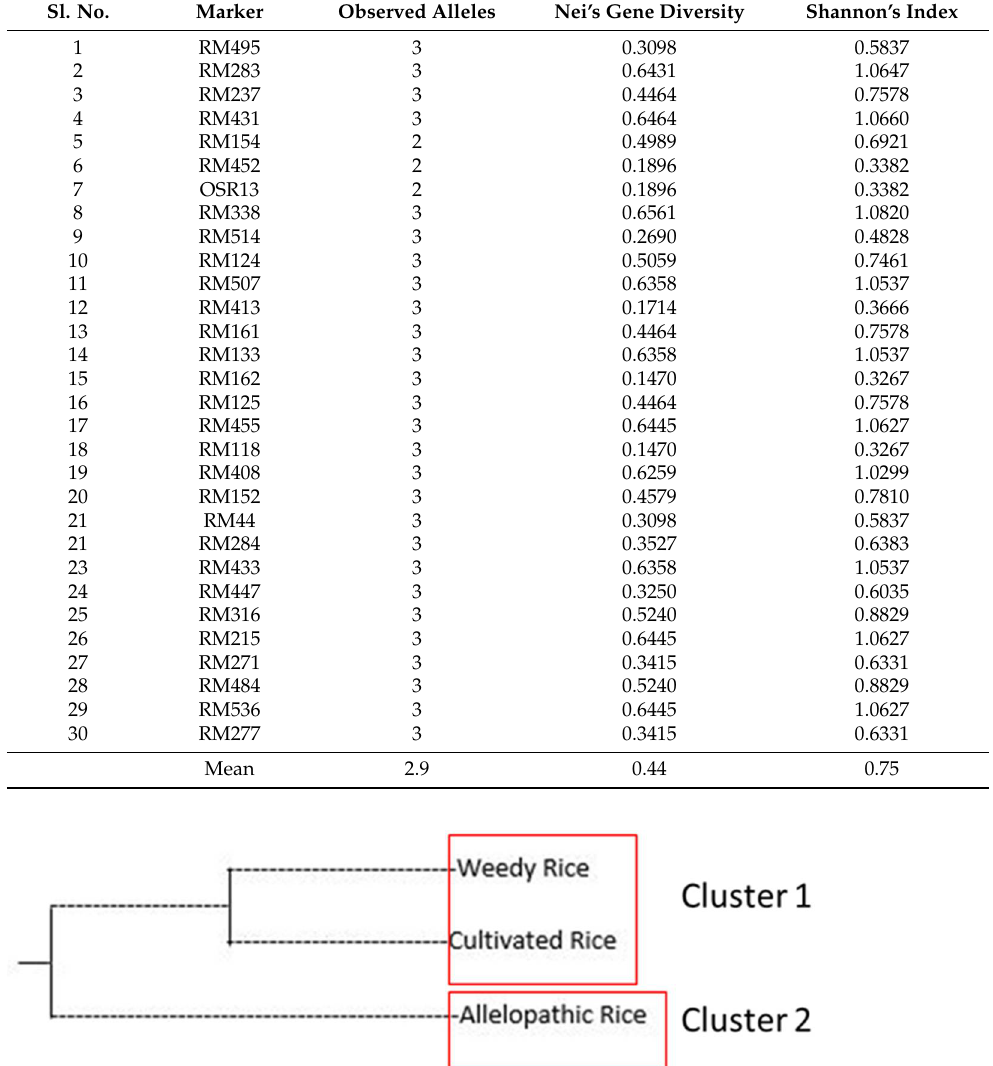
Table 1. Genetic variation among the population (weedy rice, cultivated rice, and allelopathic rice) indicated through allele’s number, Nei’s gene diversity, and Shannon’s Index.